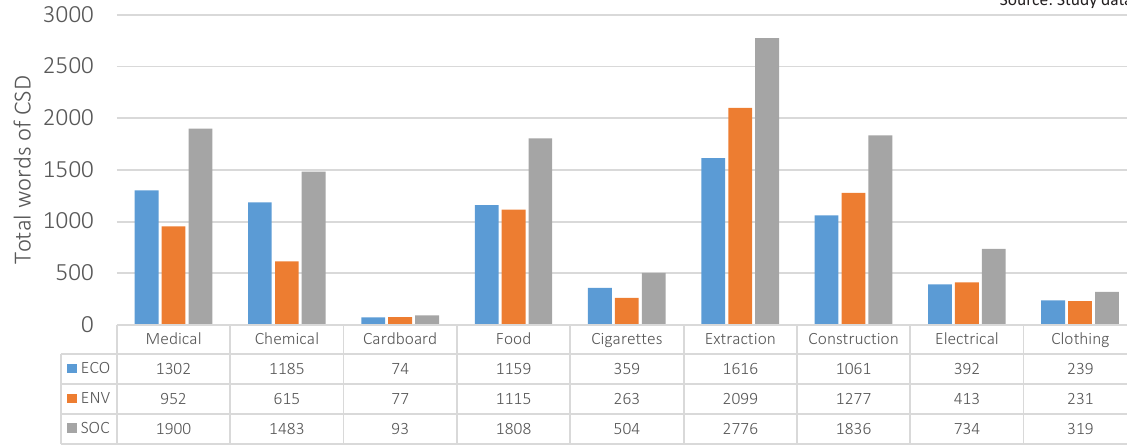
Figure 2. Total words of sustainability disclosure by sub-sectors